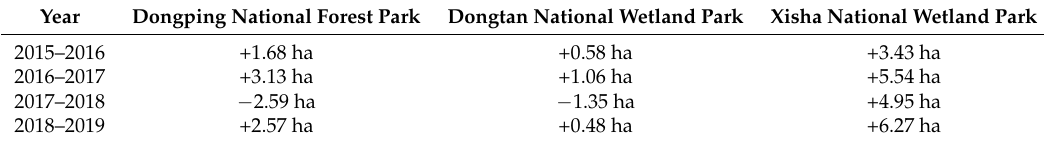
Table 4. Forest area change in the three strictly protected forest sites. + and − denote the increase and decrease of the forest area, respectively.